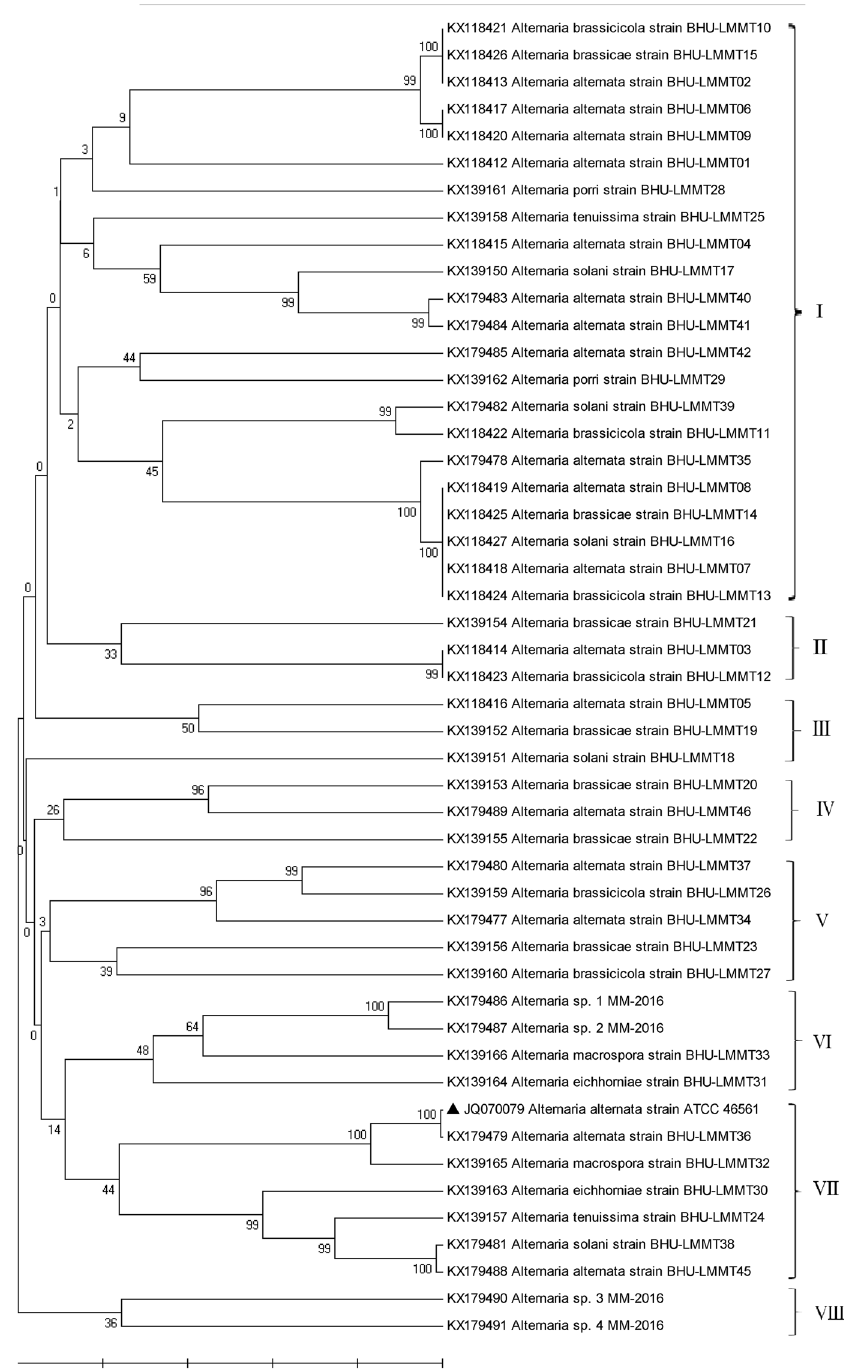
Figure 2. Phylogenetic relationship based on 18S rDNA sequences of different isolated Alternaria species. DNA sequences from the NCBI nucleotide database were aligned using the Clustal W program in MEGA 5.0, and constructed using the Neighbour-Joining method with 500 bootstrap replicates. The scale bar indicates the number of differences in nucleotide substitutions per